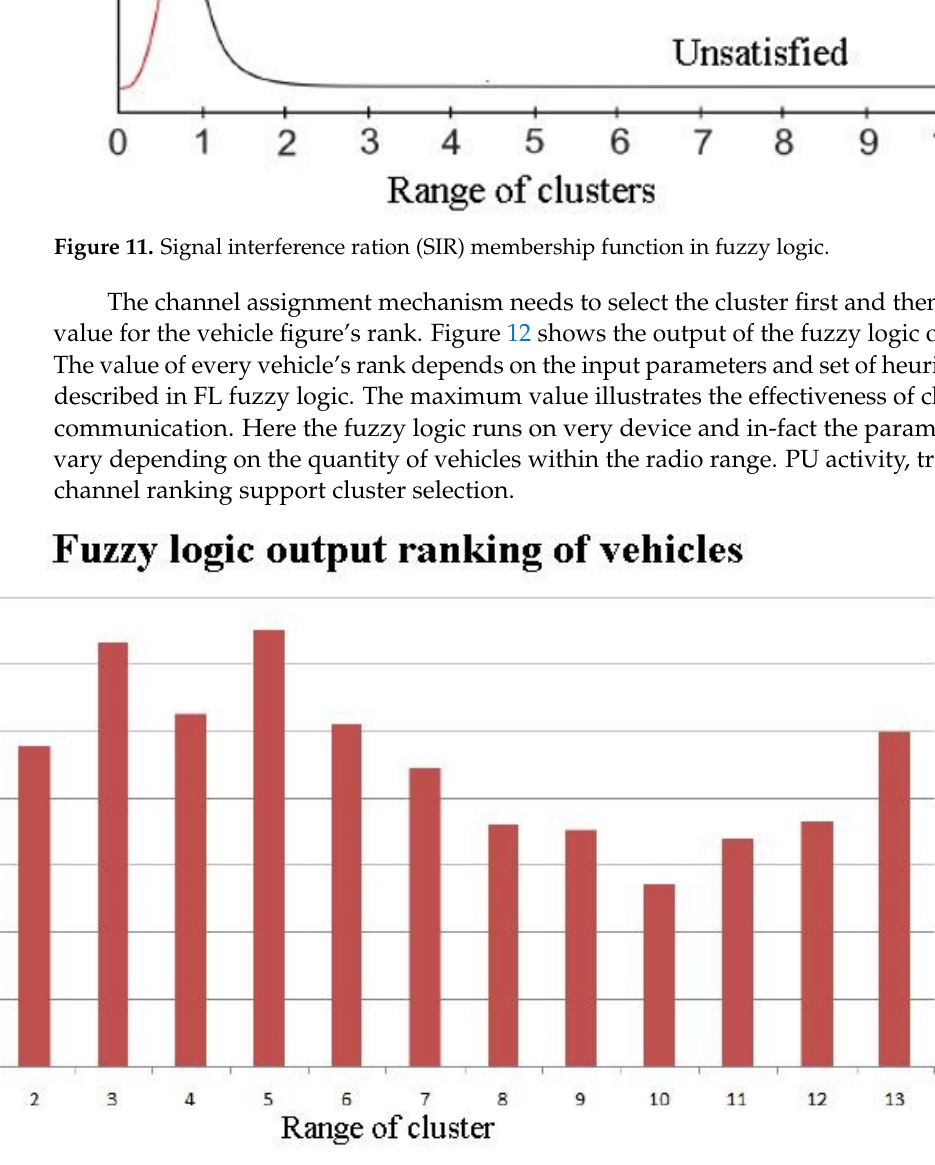
Figure 12. Fuzzy logic output ranking of vehicle.